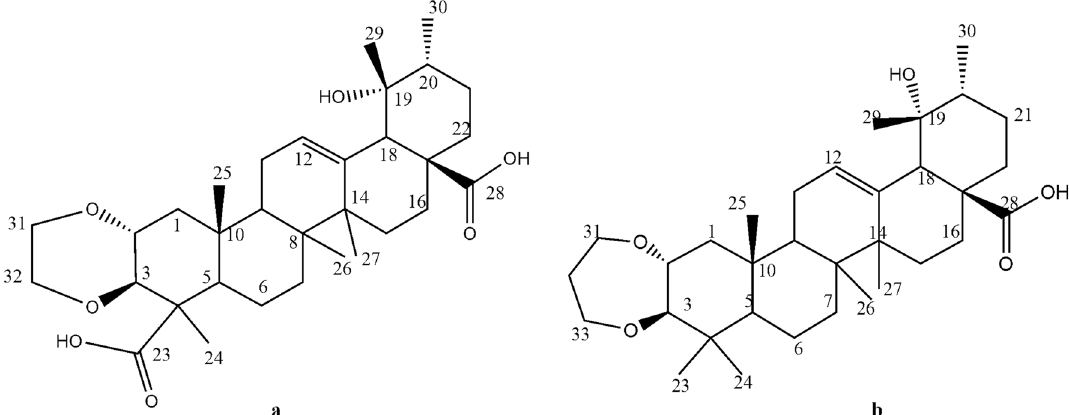
Figure 3. Structures of compounds 1 and 2 . a = 2,3-O-ethylene glycol, 19-hydroxyurs-12-en-23,28-dioic acid; b = 2,3-O-propanediol, 19-hydroxyurs-12-en-28-oic